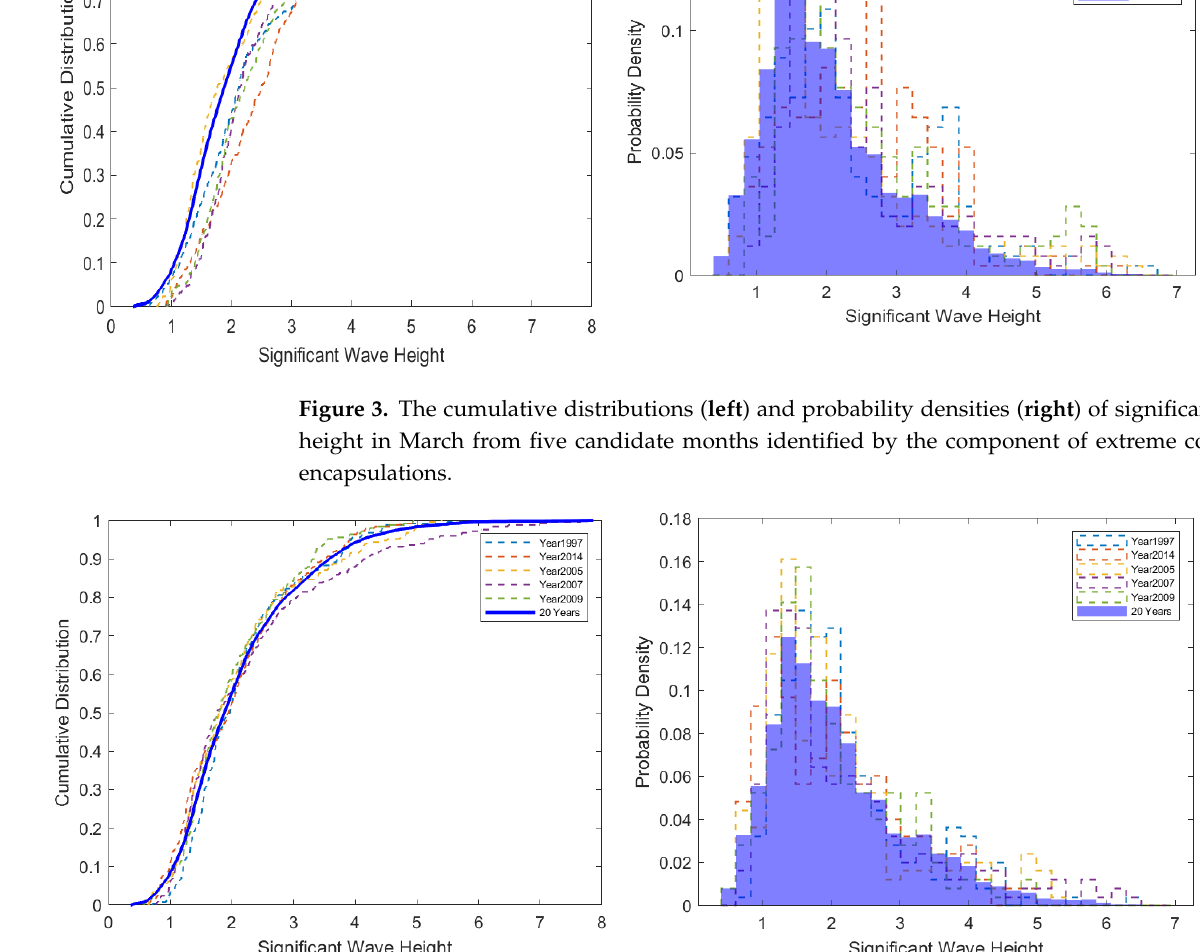
Figure 4. The cumulative distributions ( left ) and probability densities ( right ) of significant wave height in March from five candidate months yielded by the component of vessel accessibility.